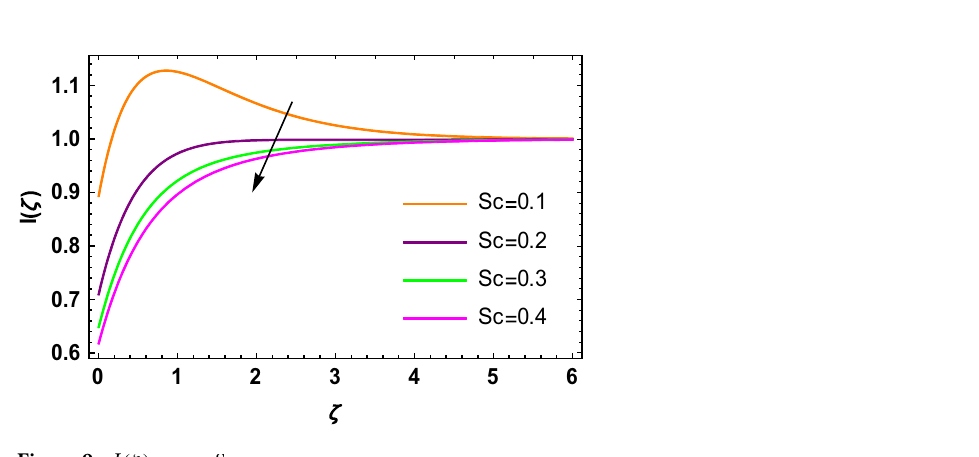
Figure 9. I (ζ) versus Sc